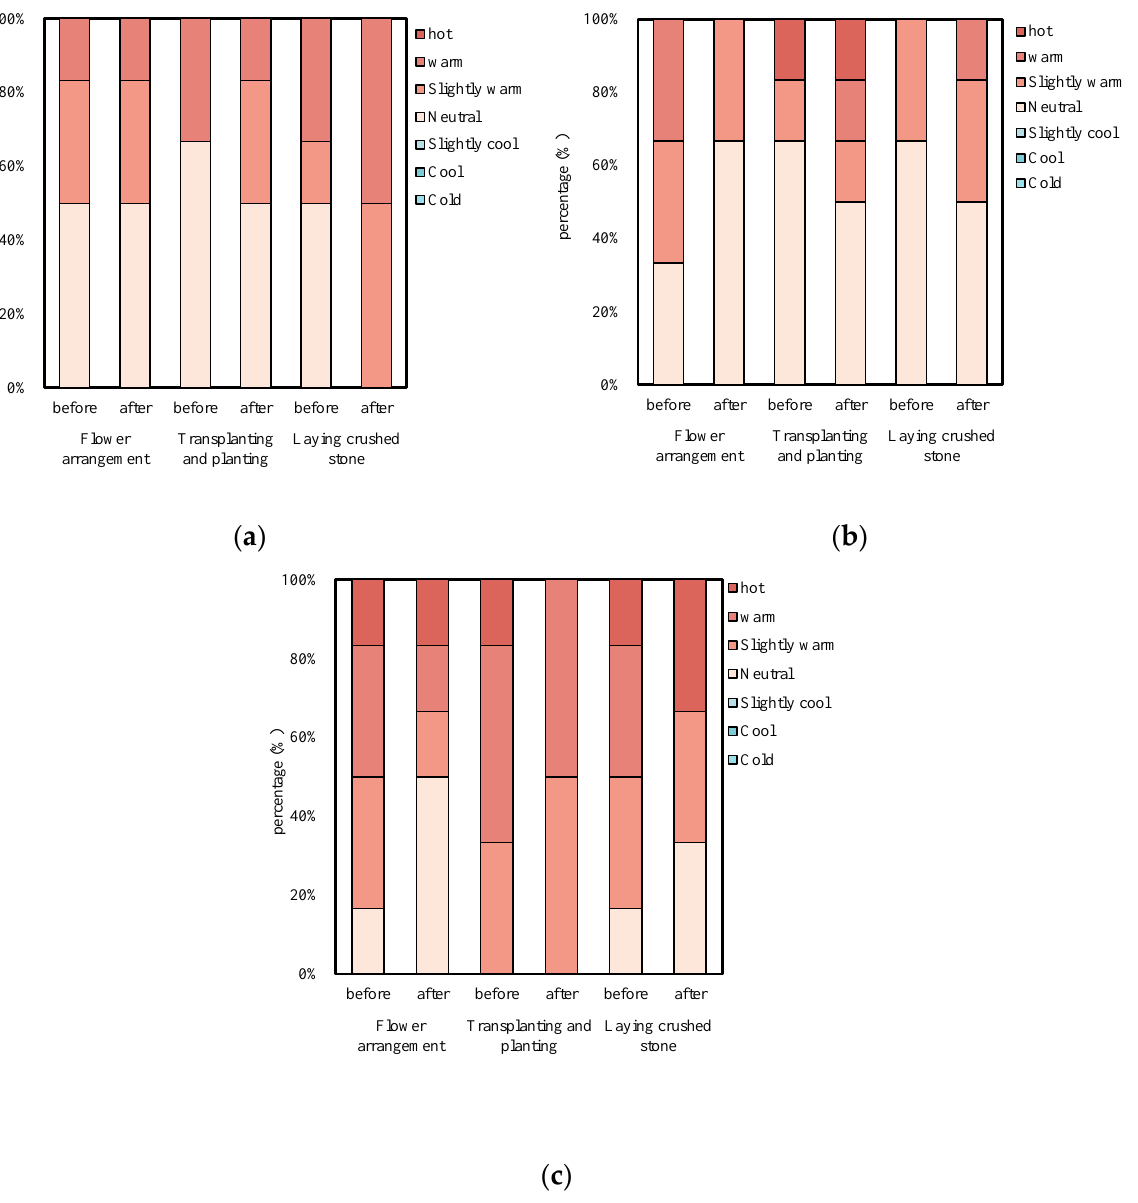
Figure 4. Percentage change of TSV before and after horticultural activities (( a ) PA, ( b ) TS, and ( c ) OS).